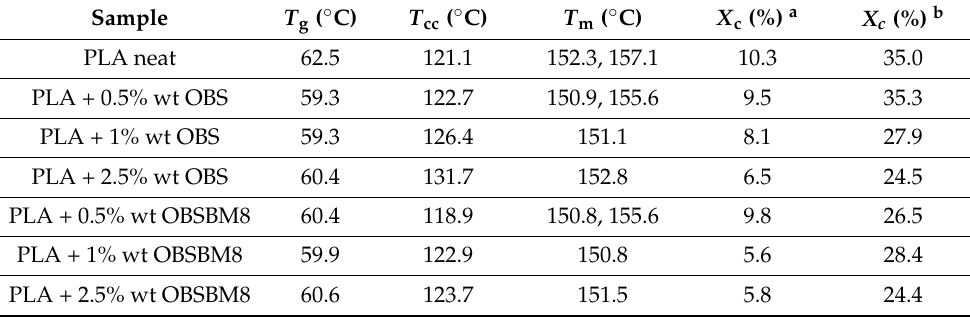
Table 1. Thermal characteristics of PLA and its composites with PLA obtained by DSC (second scan).